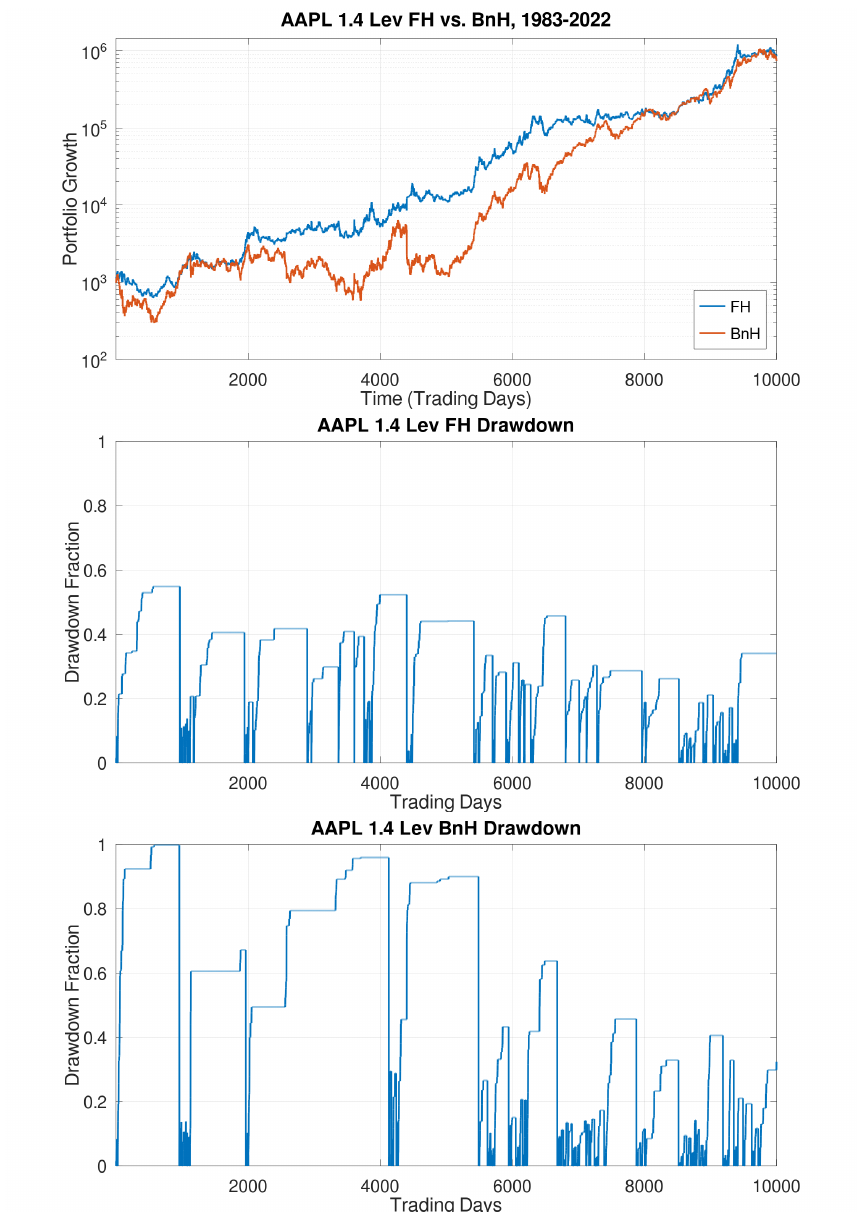
Figure 12. ( top ) The performance of a FastHedge algorithm for trading AAPL stock with 1.4X leverage (when long) over a 40-year period ending 31 December 2022, compared to BnH (plotted without leverage). ( middle ) An indication of the drawdowns for the FastHedge algorithm over the 40-year period, and ( bottom ) of the 1.4X leveraged BnH algorithm with AAPL stock, with catastrophic losses nearing